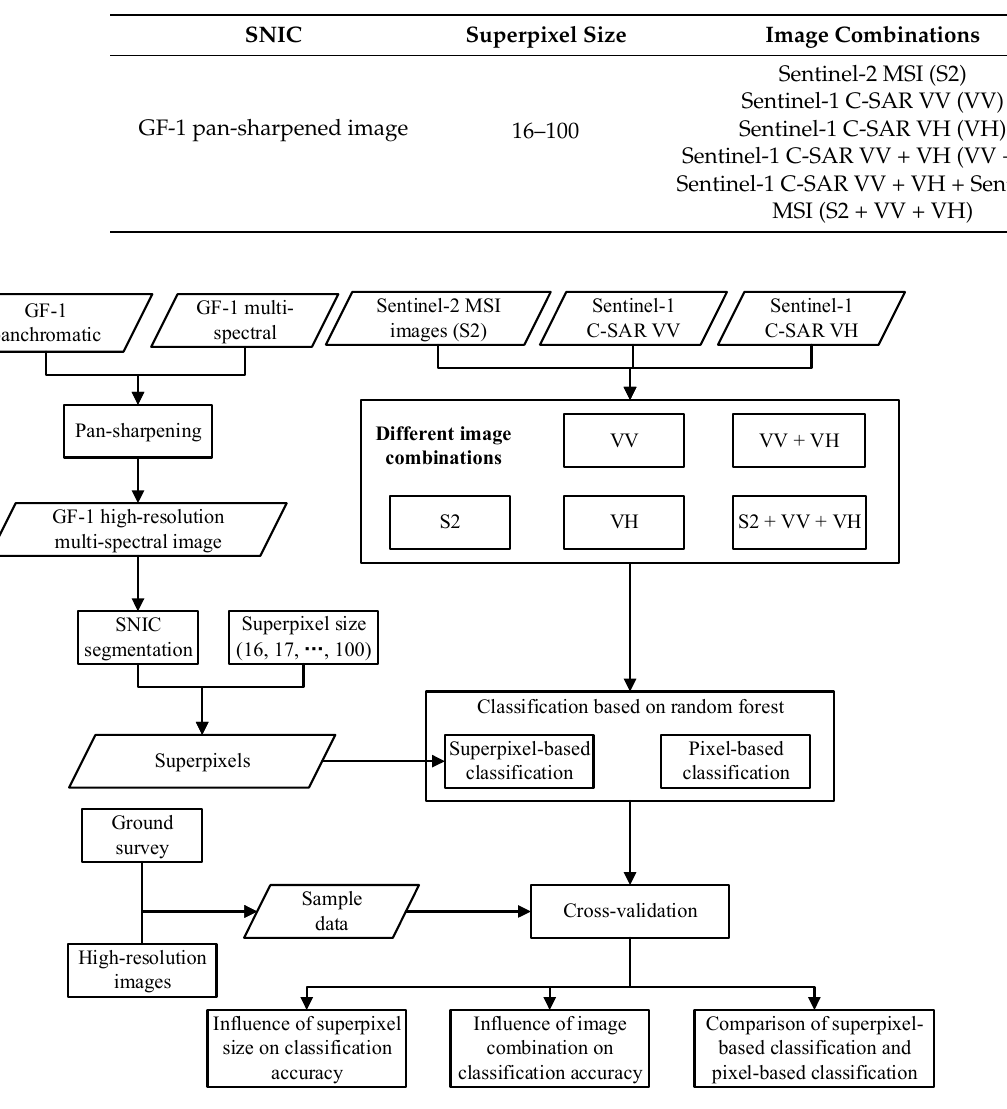
Figure 7. Methodological workflow employed in the current study.